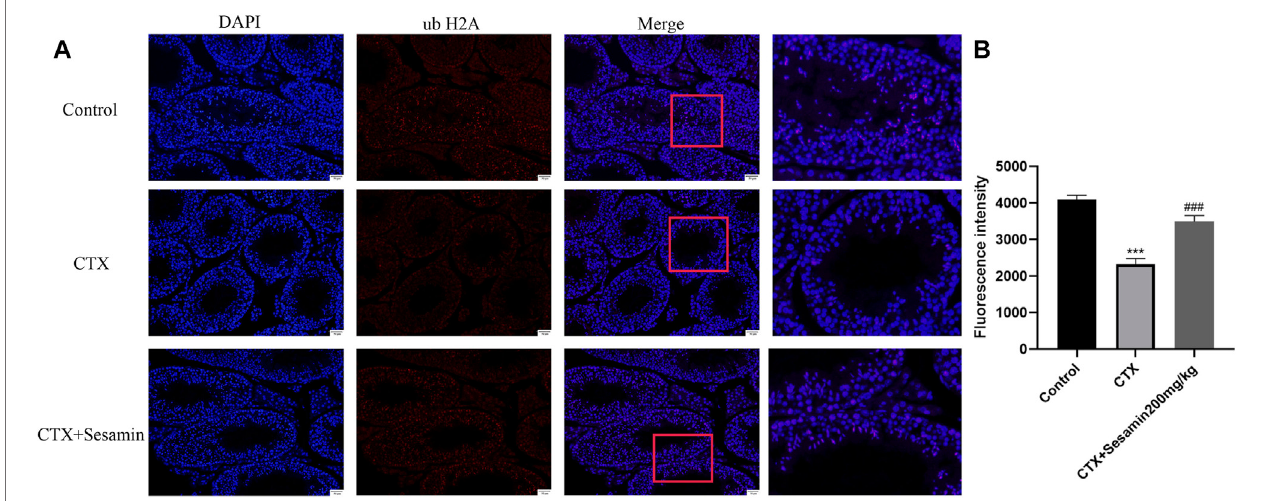
FIGURE 9 | The expression of ubiquitin histone H2A in the testis. The representative fl uorescence photomicrographs in the seminiferous epithelium cycles of the testis at 200 × magni fi cation (scale bar (cid:2) 50 μ m). (A) Theimmuno fl uorescence analysis ofubiquitin histoneH2A inthe seminiferous tubuleat stages Ⅺ – Ⅻ . (B) Statistical analysis of the fl uorescence intensity of ubiquitin histone H2A in the different groups. The data indicate the mean ± standard error (n (cid:2) 6). *** p < 0.001 vs. the control group; ### p < 0.001 vs. the CTX group.